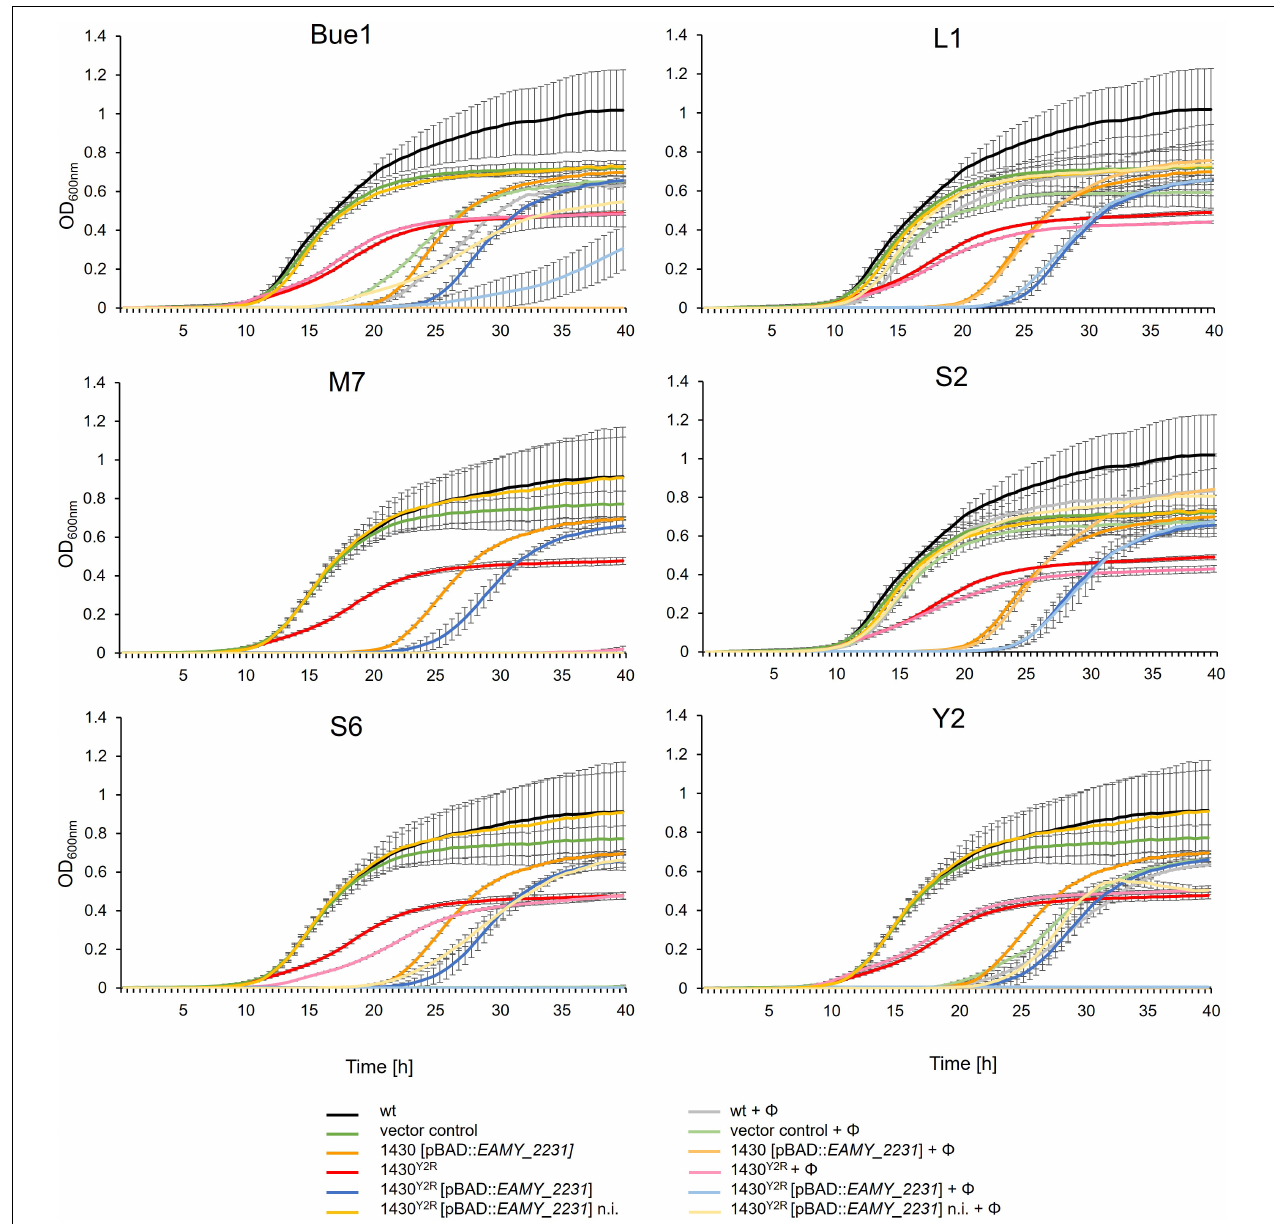
FIGURE 4 | Phage impact on growth of different strains. The wild type (wt), the empty vector control, the overexpression of EAMY_2231 (1430 [pBAD18: EAMY_2231 ]) the spontaneous Y2 resistant strain 1430 Y 2 R , and 1430 Y 2 R [pBAD18: EAMY_2231 ] were incubated with the phages ( (cid:56) ) Bue1, L1, S2, S6, M7, and Y2 or without phages as control. Error bars indicated standard deviation. n.i., not induced.The experiment was performed with three biological and three technical